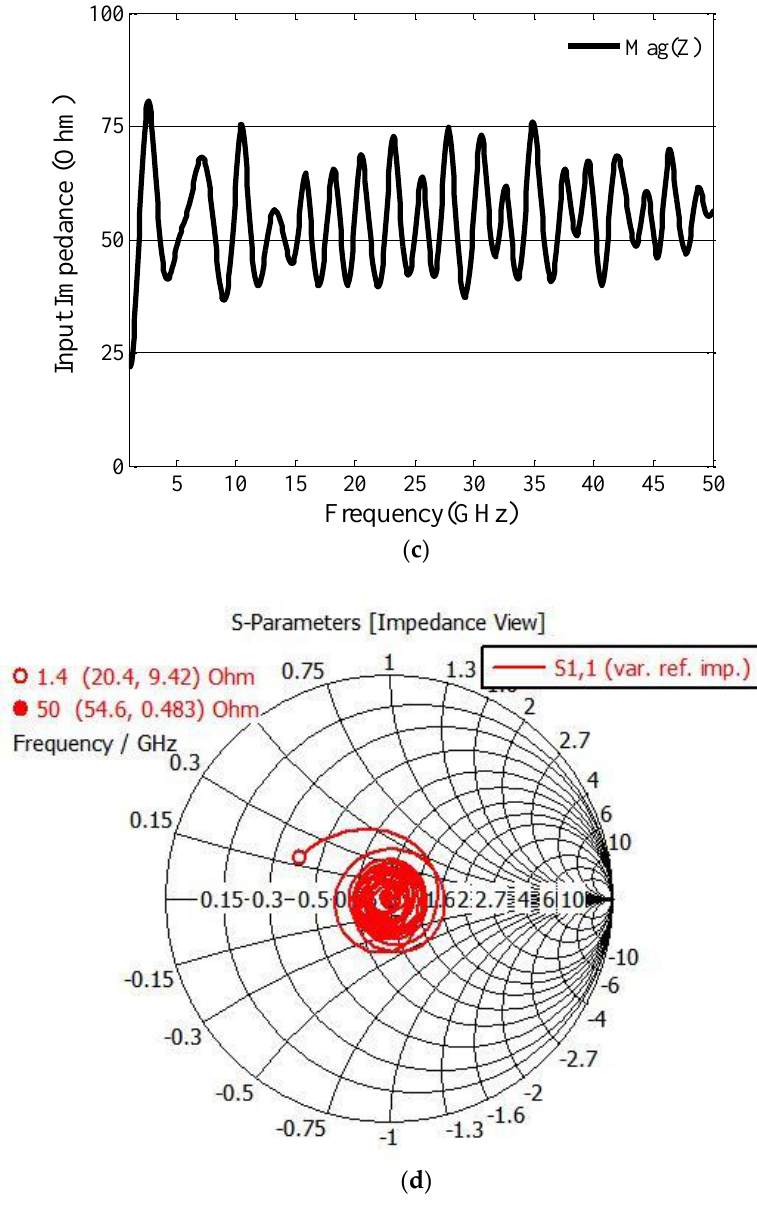
Figure 7. The input impedance of a designed SWB antenna: ( a ) Real; ( b ) imaginary part; ( c ) magnitude; ( d ) Smith chart.